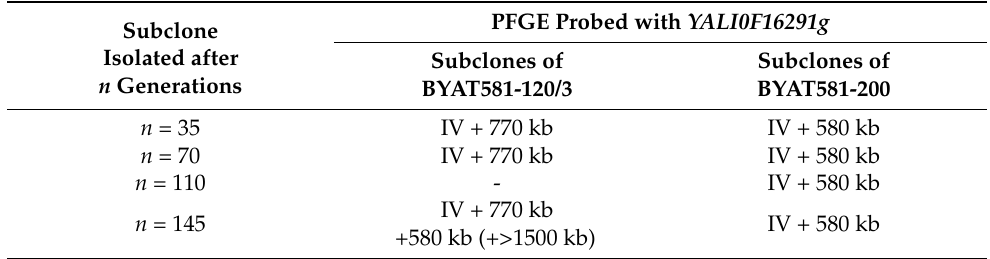
Figure 4. Cartoon representation of neochromosomes in evolved mutants. ( a ): Schematic repre- sentation of chromosomes IV and XV (red and blue lines, respectively) with centromeres (ovals), telomeres (vertical thick black bars) and neochromosomes. Amplicons are highlighted by colored bars with arrows to visualize orientation. The KRS1 locus is symbolized by blue diamonds. Top: structure observed in evolved mutants BYAT581-60 and BYAT581-120/3. Bottom: structure observed in evolved mutants BYAT581-120/1, BYAT581-200, BYAT581- 265A, BYAT581-265B and BYAT581-345. Numbered triangles point to novel junctions formed in the neochromosomes (see text). ( b ): proposed mechanism of evolution from the simple neochromosome present in BYAT581-120/3 to the partially palindromic one present in its progeny after 145 generations (BYAT581-265A and BYAT581-265B). Table 4. Stability of the 770 kb neochromosome and the 585 kb partially palindromic